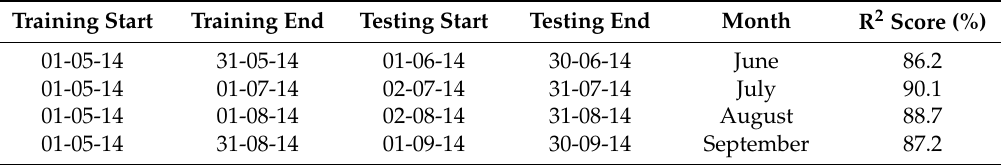
Table 4. Hour-ahead online training using a Random Forest Decision Tree.